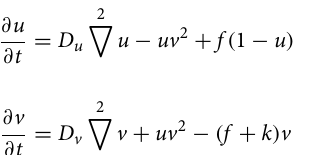
Figure 2. Self-organising mosaics generated using the Gray-Scott reaction-diffusion model. Panel ( a ) shows the output of a 300 300 element system after 20,000 time steps with coefficients: D u × k 0.065 . Panel ( b ) shows the output of a 300 300 element system after 60,000 time steps with coefficients: × = 3 r D 0.14 , D 0.4 10 0.04 , f 0.035 , k 0.065 , where r is the radial coordinate of the system, u = v = − × + = = 0.04 in the centre and D 0.12 at the furthest edge of the array. The radial variation in the resulting in D v v = = spacing of the spots arises due to the radial variation in the diffusion coefficient. It should be noted that both models were seeded with the chemicals initially in the centre, and, in ( b ), the simulation has been terminated before the chemicals have diffused to the edge of the system so as to produce a circular, rather than square, arrangement of spots for display